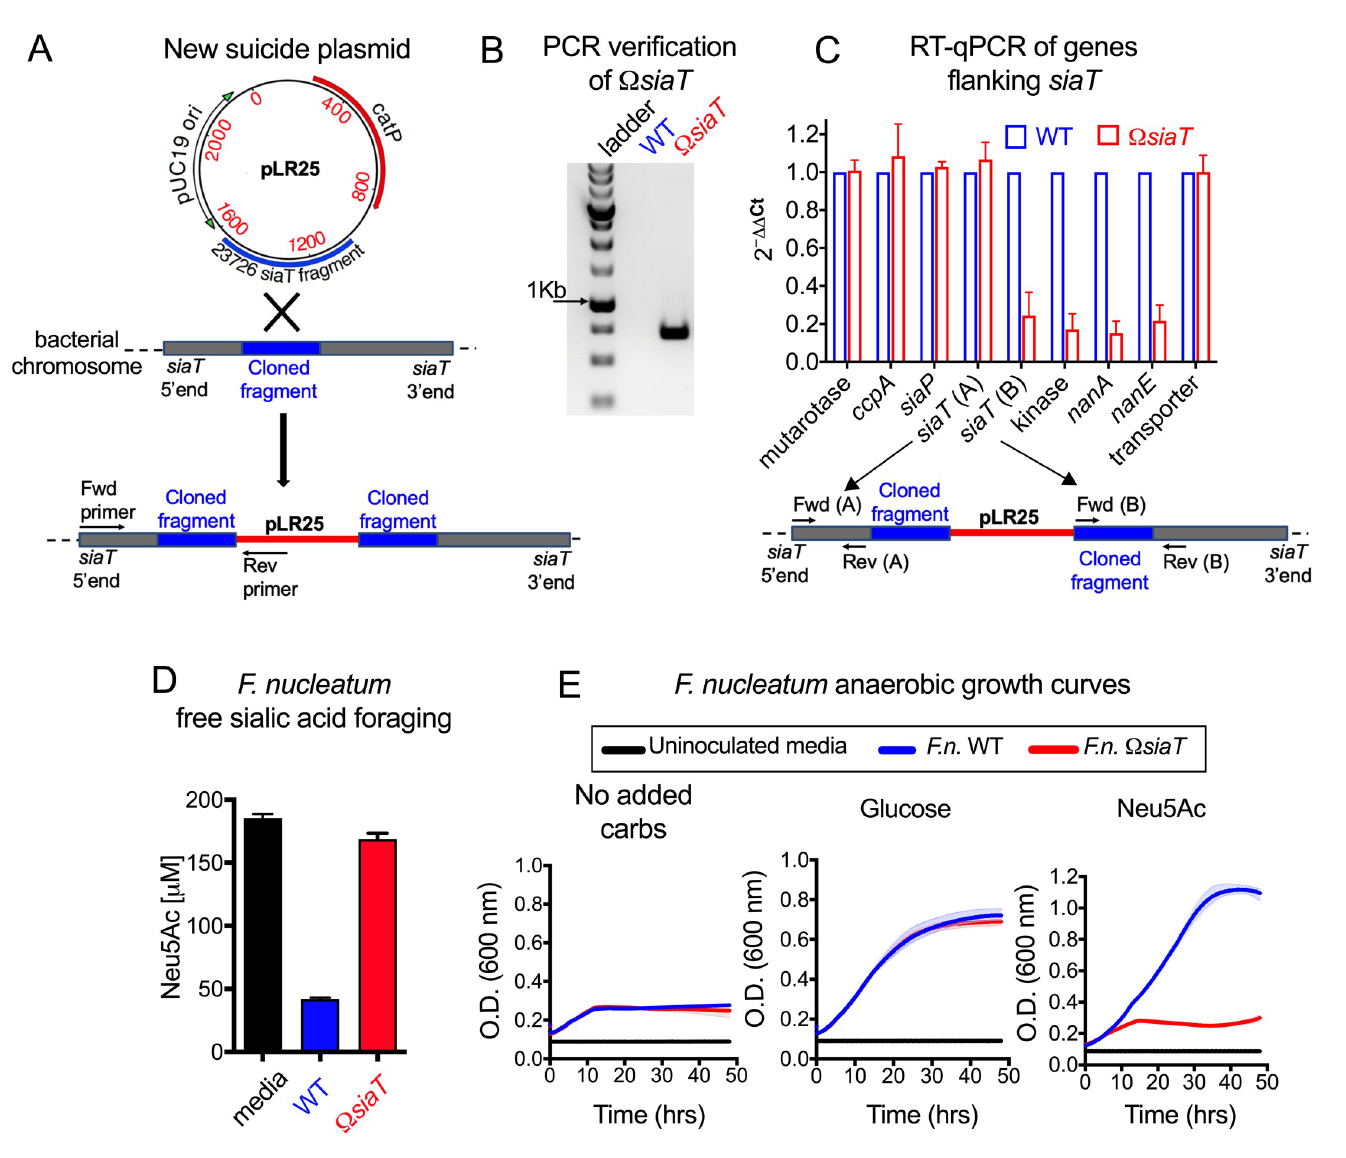
Fig 2. Insertional mutagenesis to disrupt sialic acid catabolic pathway in F . n . ATCC23726 and growth analysis in nutrient-limited media. (A) Schematic showing integration of plasmid containing siaT insert (pLR25) into the F . n . chromosome. Positions of Fwd and Rev primers used for confirming integration of plasmid are also indicated. (B) Agarose gel image with the expected PCR product confirming integration of plasmid into the siaT locus. (C) RT-qPCR analysis of genes flanking siaT in F . n . shows low expression of transcripts of putative sialic acid catabolism genes downstream of the plasmid insertion site. Difference in expression of each gene between F . n . WT versus O siaT was analyzed by the ΔΔ Ct method using the 16S rRNA gene for normalization. Fwd and Rev primer binding sites are indicated by arrows in the schematic below the graph. (D) Functional assessment of the WT and O siaT strains confirms disruption of sialic acid catabolism. Shown is the concentration of sialic